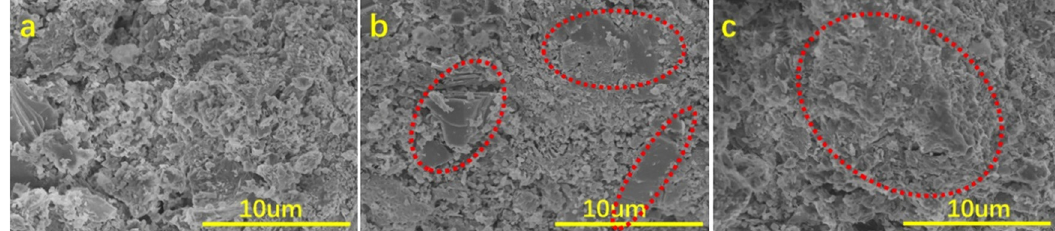
Figure 21: SEM images of hydration products in cement composites at 7 days: ( a ) plain, ( b ) GO, and ( c ) GO – NS [ 136 ]